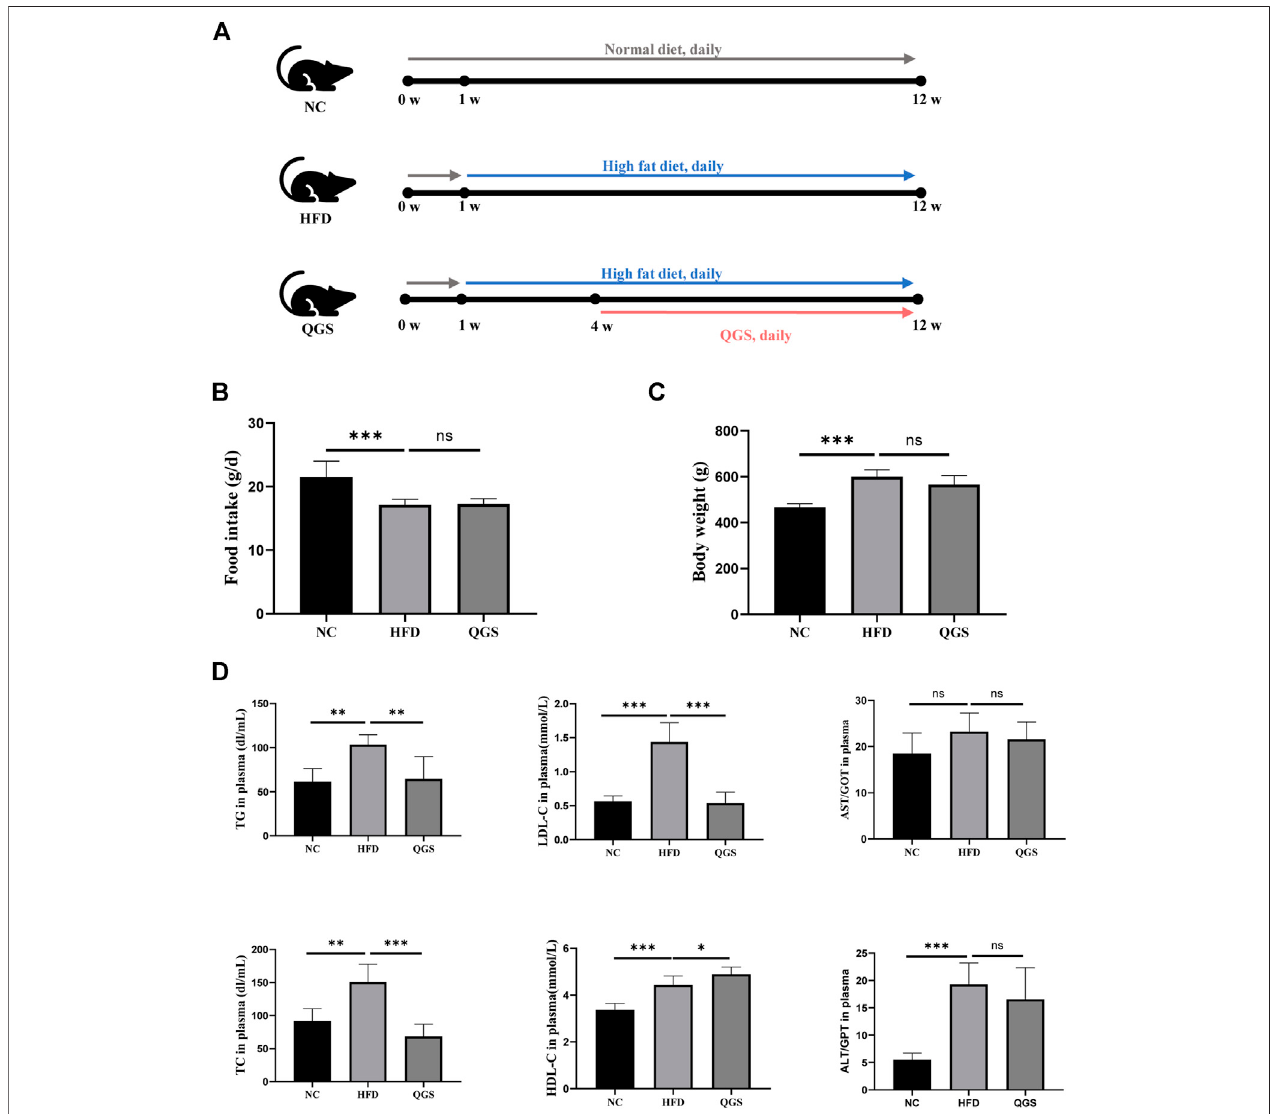
FIGURE 2 | Effects of QGS on MAFLD in rats. (A) Flow cytometry. (B) Food intake of rats at the 8th week. (C) Body weight of rats at the 8th week. (D) Measurements of TC, TG, LDL-C, HDL-C, AST, and ALT in plasma. The data are presented as means ± SEM; ns, no signi fi cant difference, * p < 0.05, ** p < 0.01, *** p < 0.001, vs. the HFD